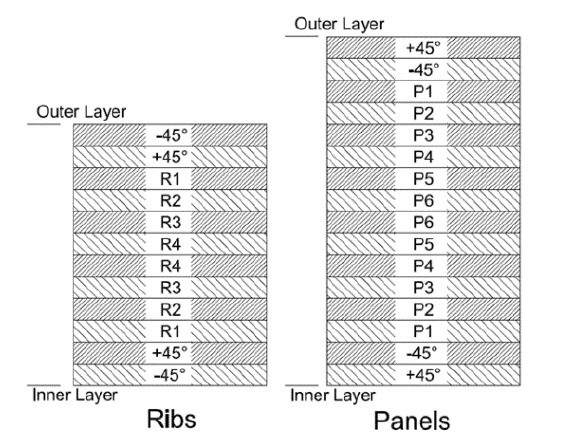
As an initial design, the two top and bottom layers’ orientations for ribs and panel are set to specific values and internal ply orientations are made variables as shown in Fig. 4. It is intended for practical industrial applica-